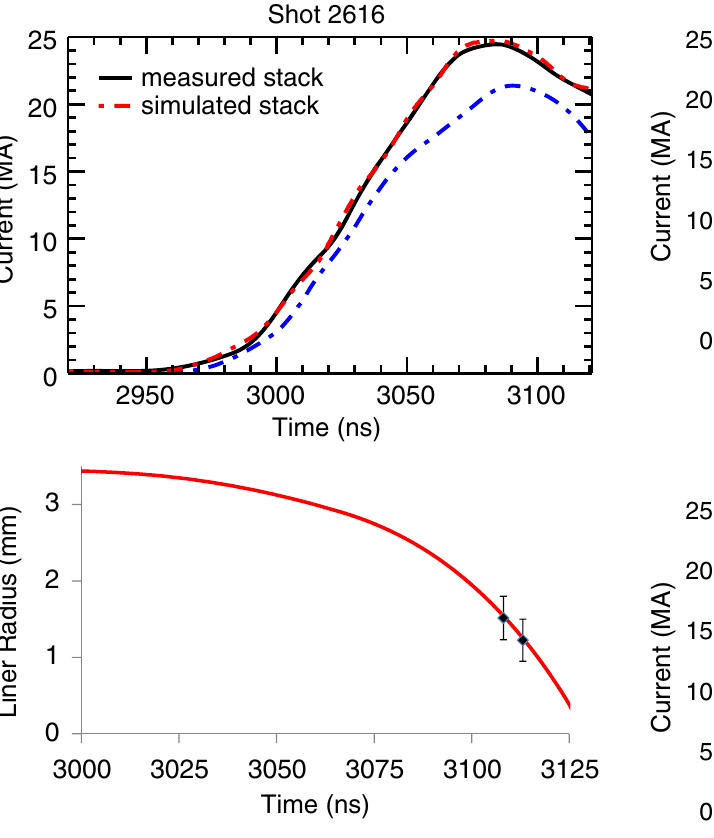
FIG. 8. Comparison of simulation and experiment results of a liner-dynamics shot. The measured insulator-stack currents agree to within 1.5%. Radiographs of the imploding liner were taken at two points during the implosion. The radii of the inner and outer surface of the liner as seen in radiographs of the imploding liner are shown using the error bars. The average radius is shown using data markers. The simulated liner radius is shown in red [17 – 19].